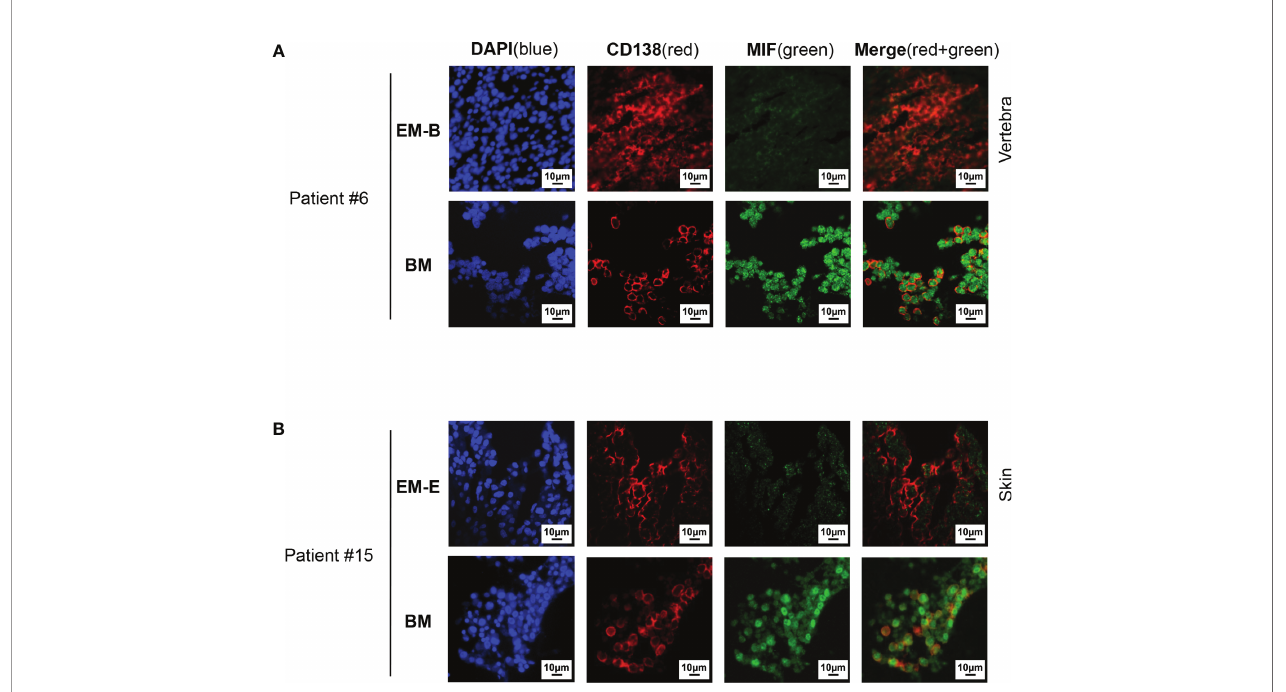
FIGURE 2 | Immuno fl uorescence staining of MIF expression in EMM versus corresponding IMM. (A, B) Differential MIF expression in paired samples is also con fi rmed by opal multicolor staining in representative cases, including EM-B (A) and EM-E (B) (DAPI represents nuclear, red represents CD138, and green represents MIF; original magni fi cation